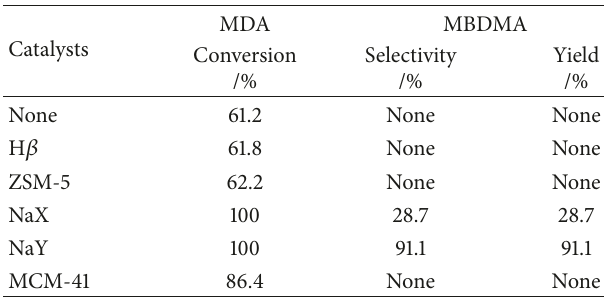
Table 1: Formation of MBDMA over various catalysts.